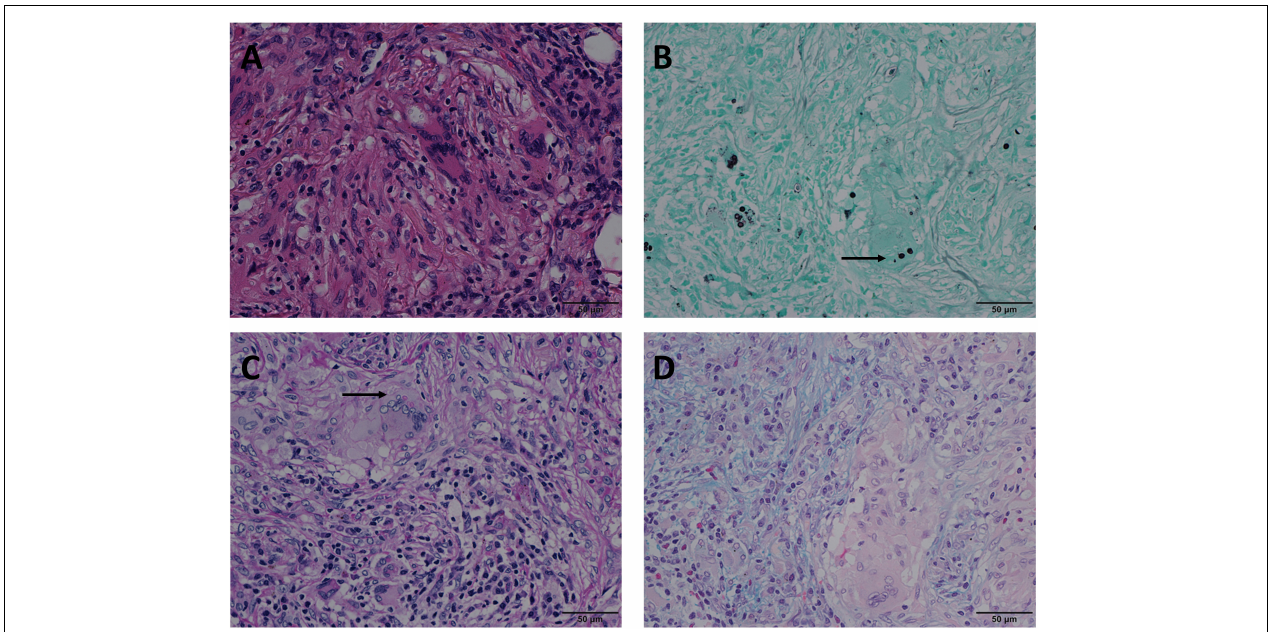
FIGURE 2 | Mode B: GMS(+), PAS(+), AB(–) in the same view of lung tissues with pulmonary cryptococcosis (male, aged 66 years, solitary nodule, maximum diameter of 0.8 cm). (A) H&E staining reveals circular structures resembling Cryptococcus spores. (B) GMS(+) shows brown-black Cryptococcus spores (arrow) that are clear and intuitive. (C) PAS(+) shows Cryptococcus spores (arrow) stained magenta and non-specific staining interference of neutral mucosubstances and glycogen. (D) AB(–) shows no obvious Cryptococcus blue but reveals non-specific staining comparable to the Cryptococcal structure. GMS, Grocott methenamine silver; PAS, periodic acid-Schiff; AB, Alcian blue; H&E, hematoxylin and eosin. (Original magnifications: A–D , × 400).